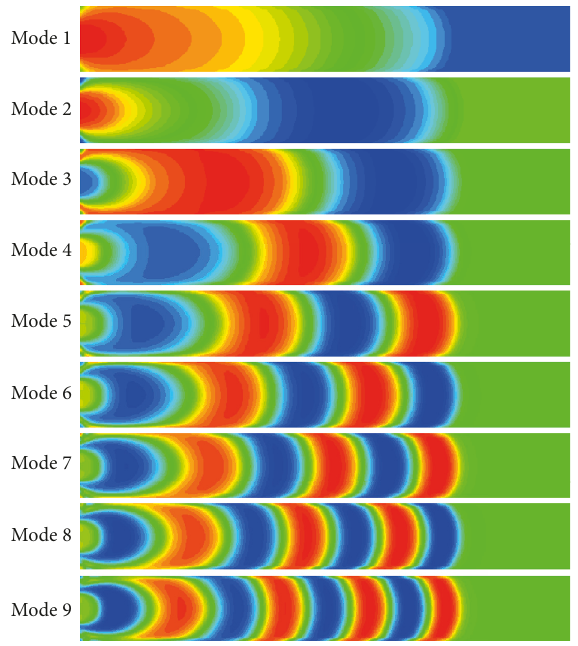
Figure 8: Flame propagation of the initial stage for the di- mensionless at the first 9 different modes.